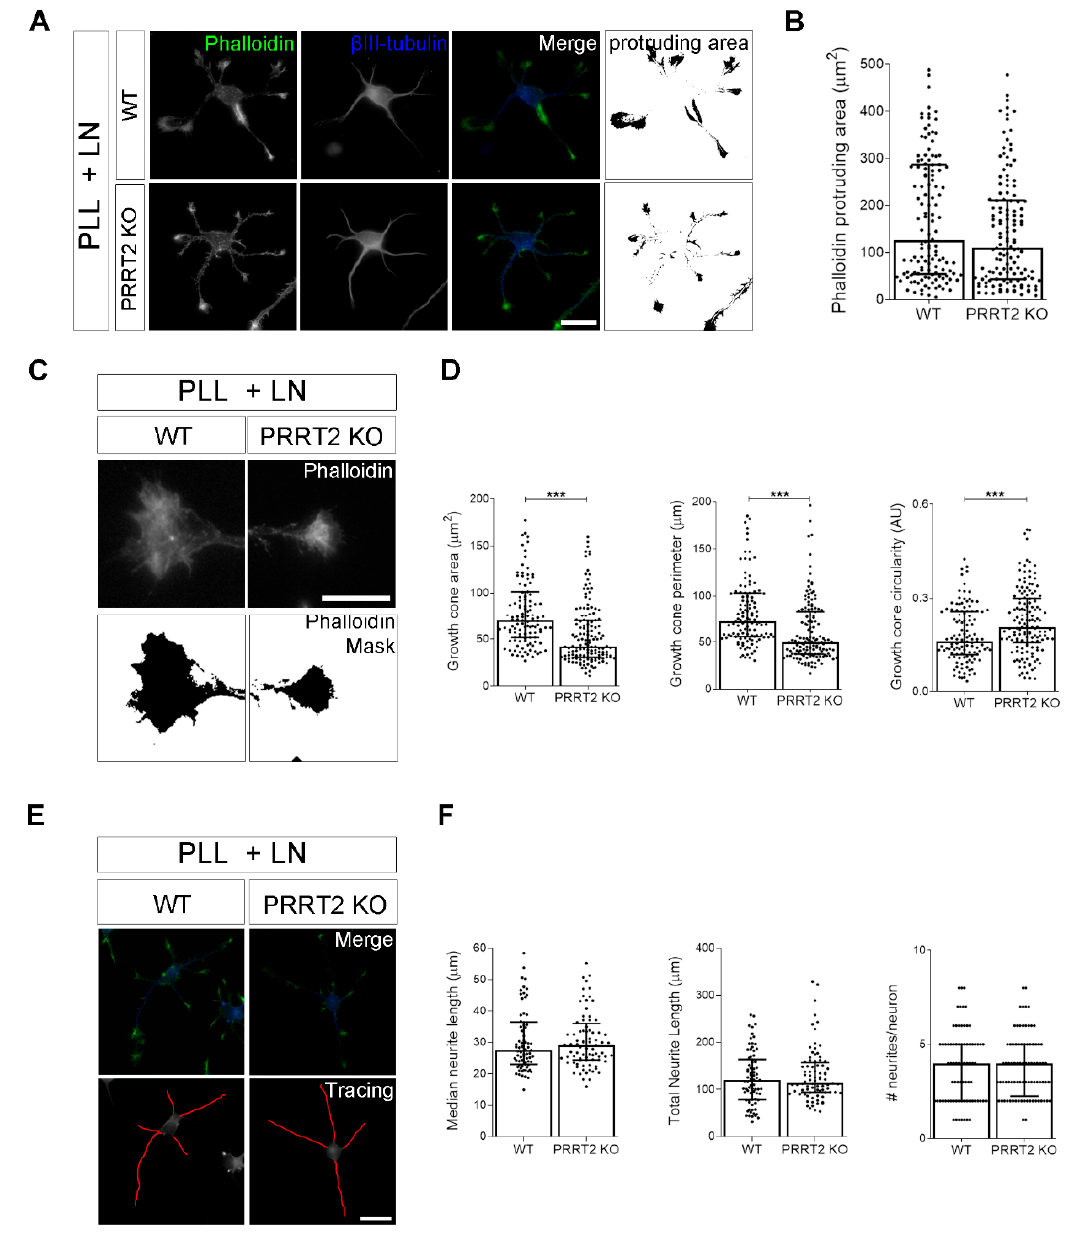
Figure 4. The loss of PRRT2 in hippocampal developing neurons plated on laminin disrupted growth cone size and complexity. ( A ) Representative images of 1 DIV WT and PRRT2 KO hippocampal neurons plated on poly- L -lysine and laminin (PLL + LN). Neurons were labelled with phalloidin to stain F-actin and β III-tubulin for neuronal microtubules. Scale bars = 20 µ m. ( B ) Quantitative evaluation of actin protrusion areas. Actin protrusion area was calculated by subtracting the area of β III-tubulin signal from F-actin area. Data are expressed as median values ± interquartile range of n = total number of neurons from four independent cultures (WT = 130, PRRT2 KO = 134). Median F-actin protruding area ( µ m 2 ): WT = 126.2, PRRT2 KO = 110.8. Statistical significance was determined by Mann–Whitney test. ( C ) The biggest growth cone was selected from the mask of the phalloidin channel on the neurons described in ( A ), and its area, perimeter, and circularity were measured. Scale bars = 20 µ m. ( D ) Quantitative analysis of growth cone parameters. Data are expressed as median ± interquartile range of n = total number of growth cones from three independent cultures (WT = 119, PRRT2 KO = 142). Median growth cone area ( µ m 2 ): WT = 70.35, PRRT2 KO = 42.47; median growth cone perimeter ( µ m): WT = 72.28, PRRT2 KO = 50.04; median growth cone circularity (A.U.): WT = 0.160, PRRT2 KO = 0.206. Statistical significance was determined by Mann–Whitney test; *** p < 0.001. ( E ) The NeuronJ plugin of the ImageJ software was used to trace the neurites on the β III-tubulin channel of neurons in ( A ). Scale bar = 20 µ m. ( F ) Quantitative analysis of